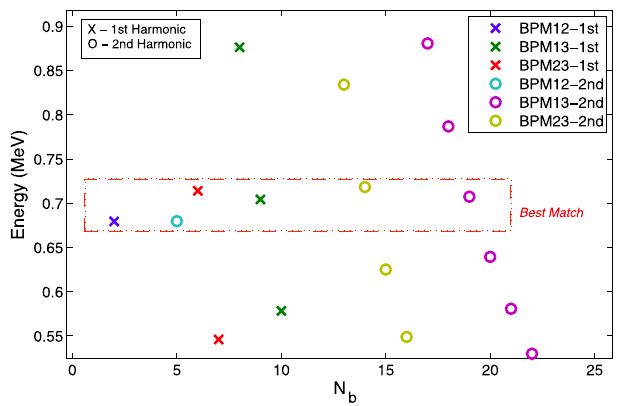
FIG. 10. By calculating the energy for different N b ’ s for all the button BPM combinations, the energy of the beam is found by finding the energy value where the points line up. In this example, both the fundamental (first harmonic) and the second harmonics are used in the calculation.